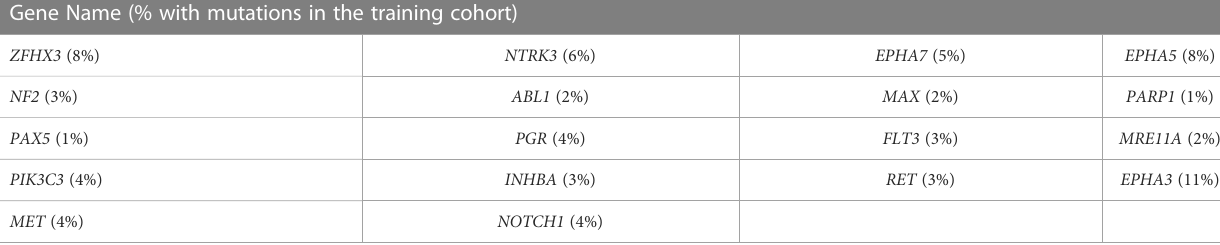
TABLE 1 List of 18 genes whose mutations could predict immunotherapy outcomes in NSCLC. Gene Name (% with mutations in the training